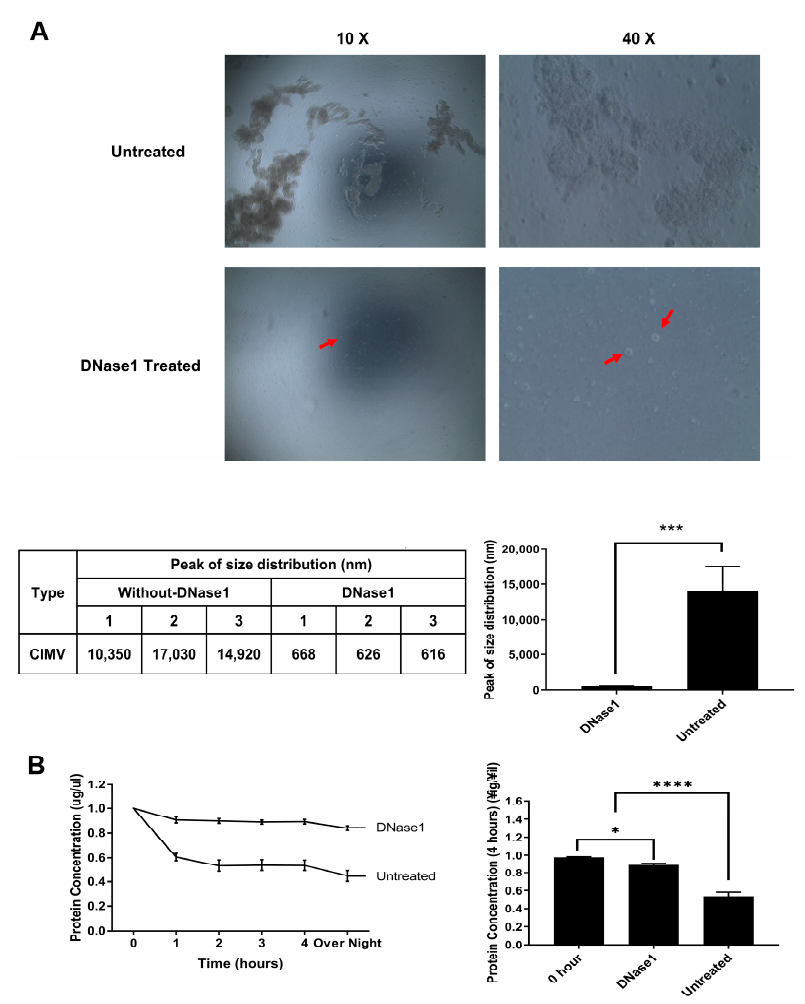
Figure 1. Inhibition of the aggregation of antigen-presenting cytochalasin-B-induced membrane vesicles (AP-CIMVs) generated from artificial antigen-presenting cells (aAPCs) by treatment with DNase1. ( A ) Image of AP-CIMVs’ aggregation without DNase1 and AP-CIMVs treated with DNase1 on Bright-field microscopy after 4 h of incubation (10×, 40× objective). Red points indicate a vesicle in the picture. Size of isolated AP-CIMVs was measured via Dynamic Light Scatter (DLS). Aggregated AP-CIMV’s diameter was measured as average of 14.1 μ m, and DNase1-treated AP-CIMV’s was 636.7 nm. ( B ) Comparison of recovery rates of non-aggregate AP-CIMVs after incubation between DNase1-treated and untreated groups. Measurement of protein amount after removal of aggregated vesicles via centrifugation after incubation at 37 °C, 5% CO 2 . The protein amount was measured via Bradford protein assay. The measurement was performed. Error bars display the mean values and ±SD of three replicates. One-way ANOVA or t -test was used to obtain the p value. * p < 0.05, *** p < 0.001, **** p < 0.0001.